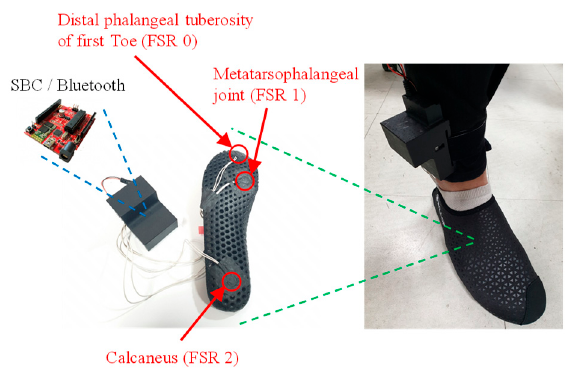
Figure 2. FSR-arrayed insole for dataset labeling of the four sub-phases in the stance phase.